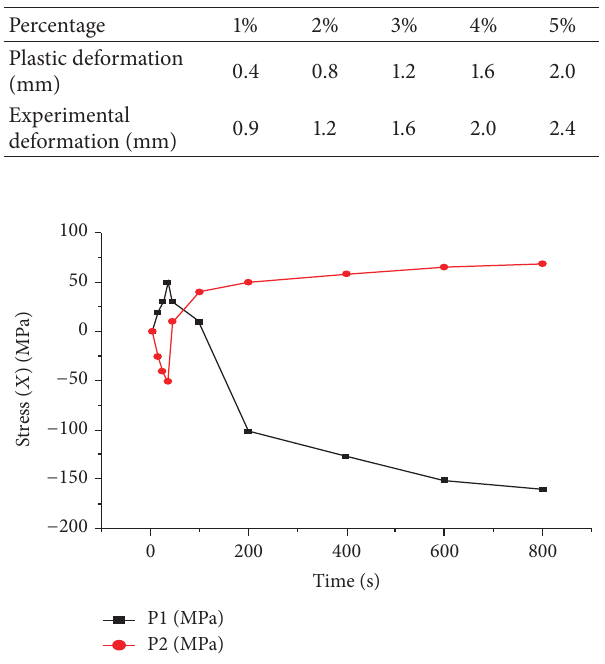
Figure 5: Stress ( X )-time curves for points 1 and 2 in Figure